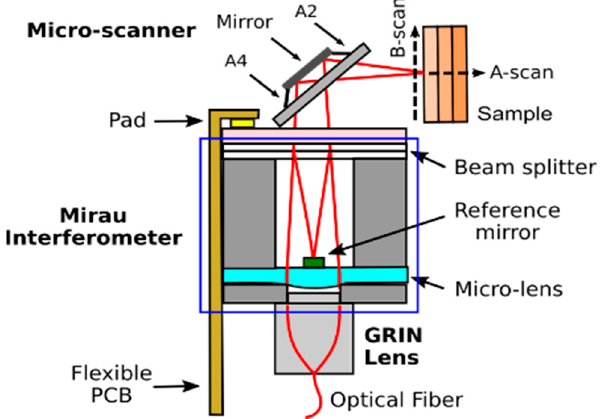
Figure 20. Schematic diagram of the MOEMS (Micro-Opto-Electro-Mechanical Systems) probe.